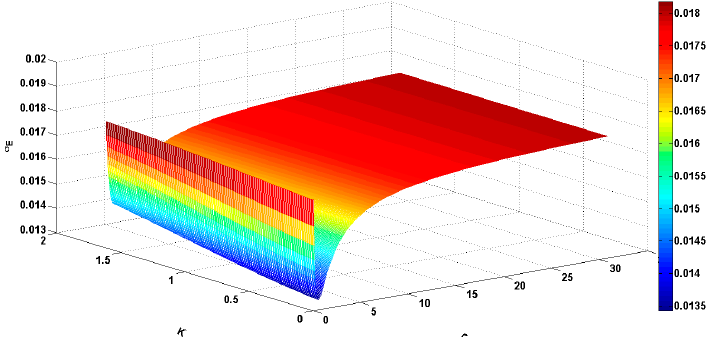
Figure 5. Mean square deviation of total vibration energy for single-DOF shear model of MTB .